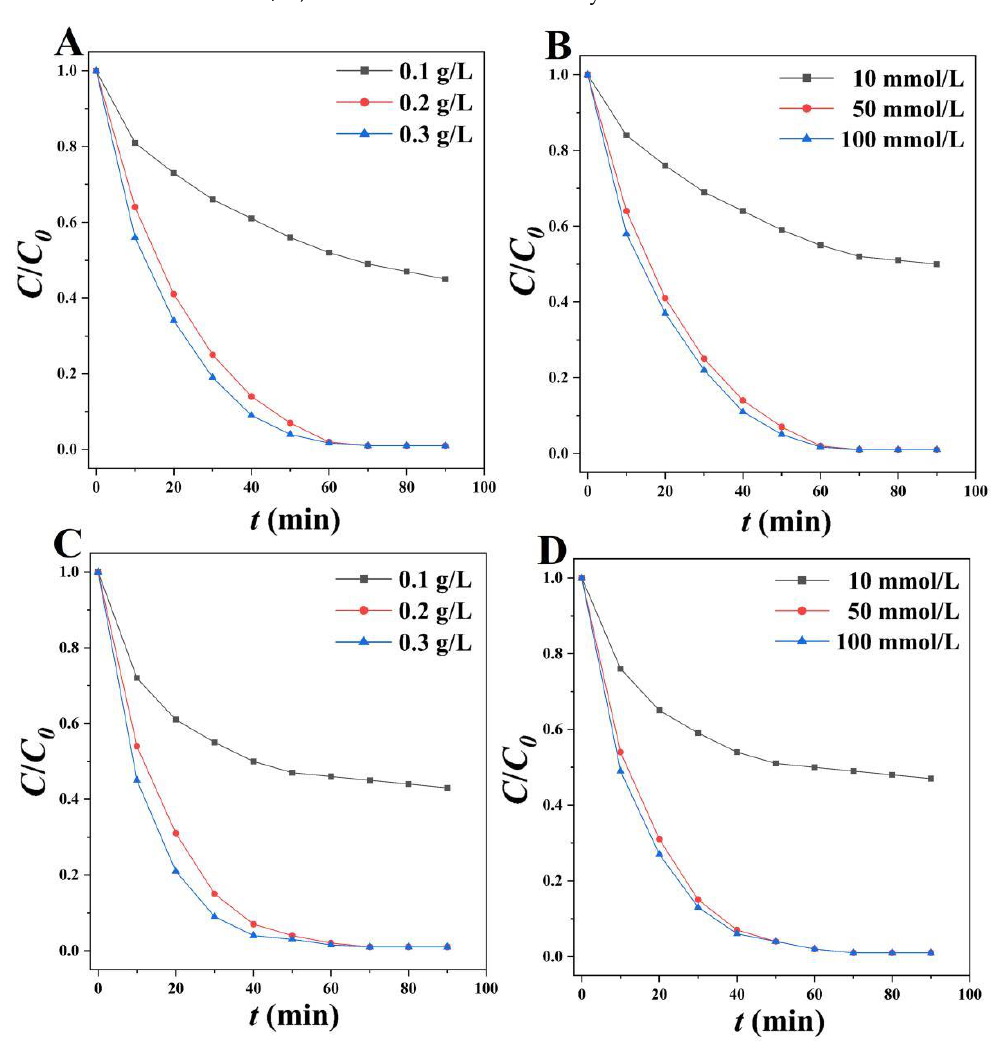
Figure 10. Effect of dosage of BMFH/Fe 3 O 4 and concentration of H 2 O 2 on the removal efficiency of ( A , B ) MG and ( C , D ) TH.